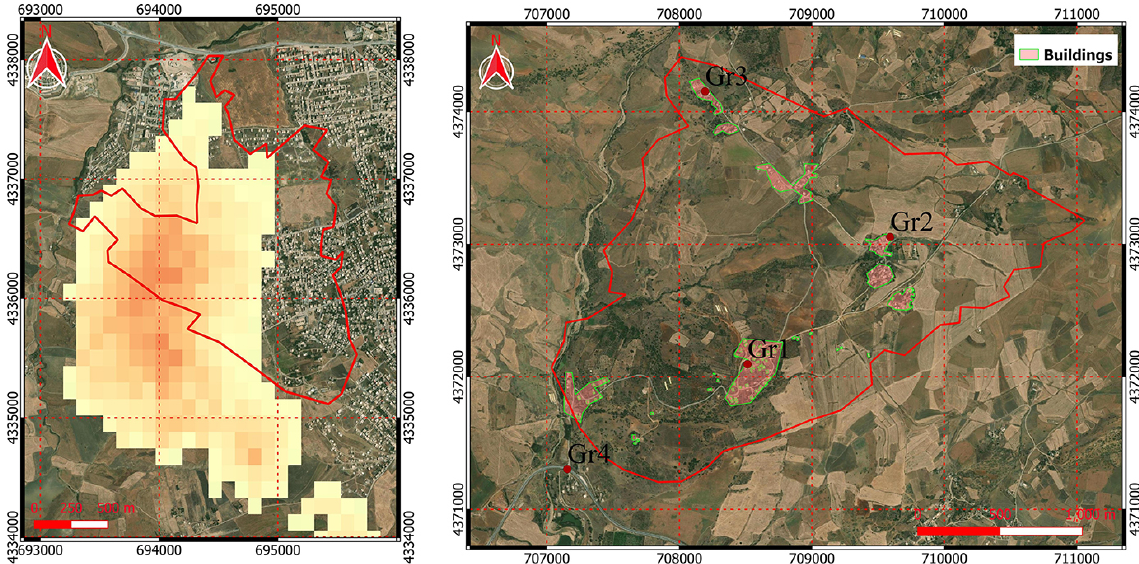
Figure 17. (a) Line-of-sight displacement velocity map; the red line is landslide area (066D_05394_131311). (b) Grarem case selected points for time-series analysis (QGIS, ESRI basemap).